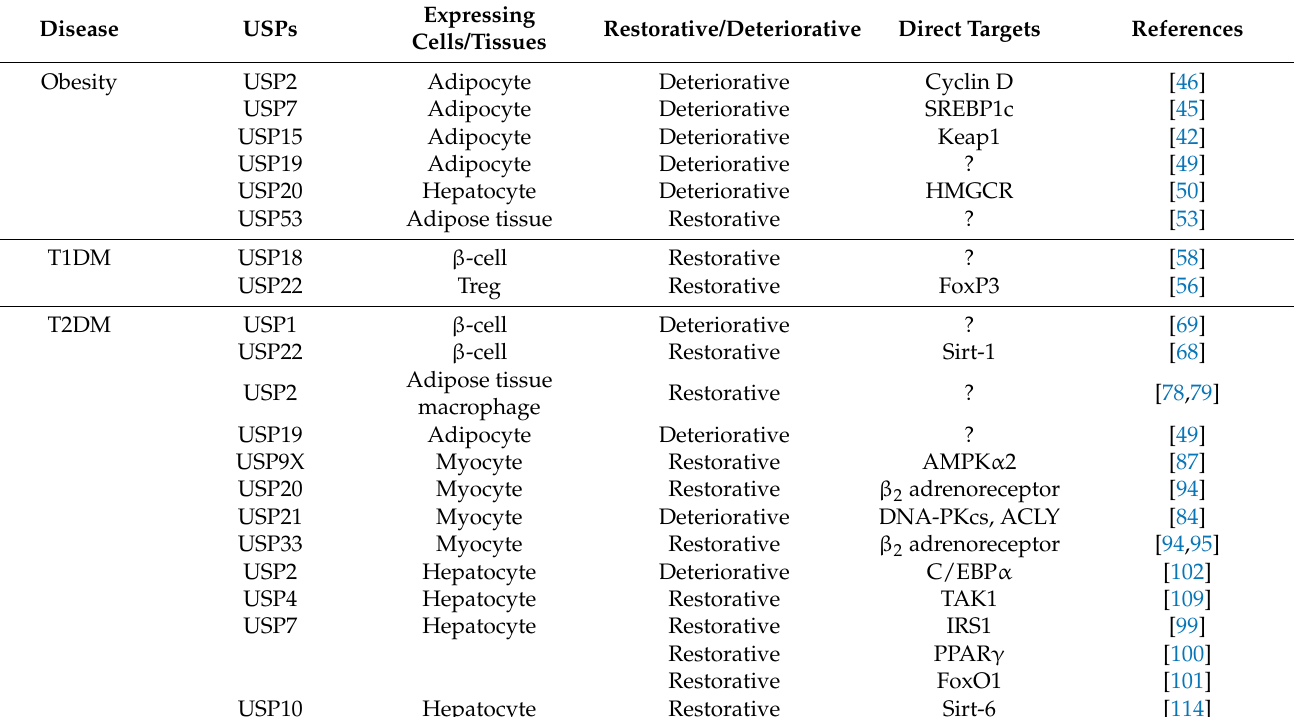
Table 1. Pathophysiological roles of USPs in metabolic disorders.